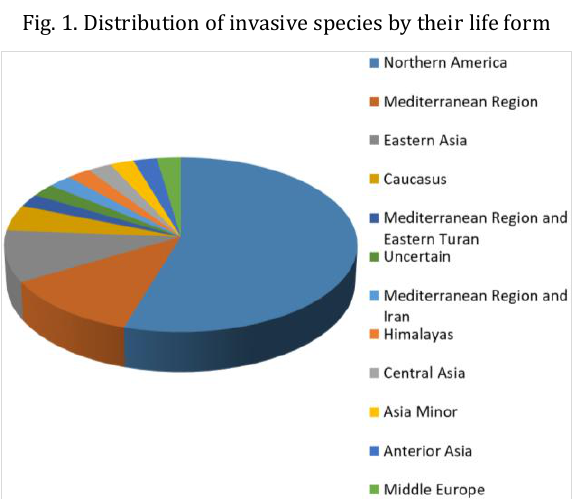
Fig. 2. Distribution of invasive species by their